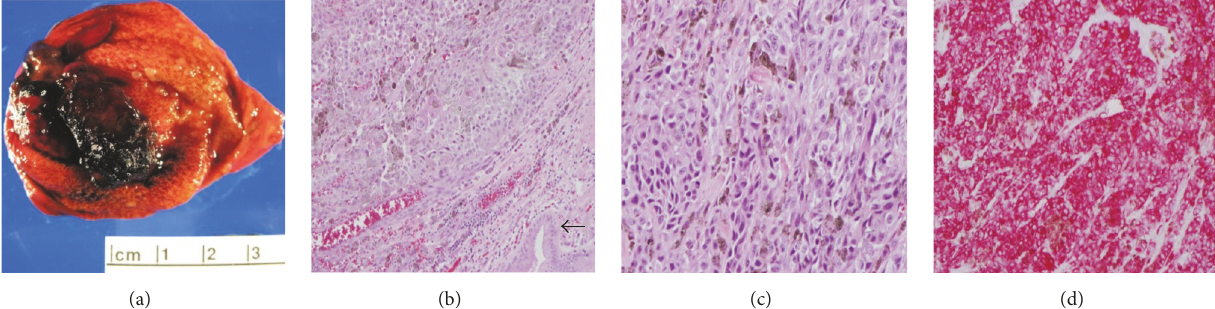
Figure 4: (a) Gallbladder mucosa with dark brown pigmented polypoid lesion measuring 2.7 × 1.5 × 1.3 cm. (b) Sheets of malignant epithelioid cells are seen with eosinophilic cytoplasm and prominent nucleoli. Gallbladder epithelium can be seen (arrow). (c) Higher power showing malignant cells with hyperchromatic large atypical nuclei with eosinophilic cytoplasm and scattered brown pigment. (d) Immunohistochemistry for melanocytic marker HMB-45 showing diffuse and strong staining.